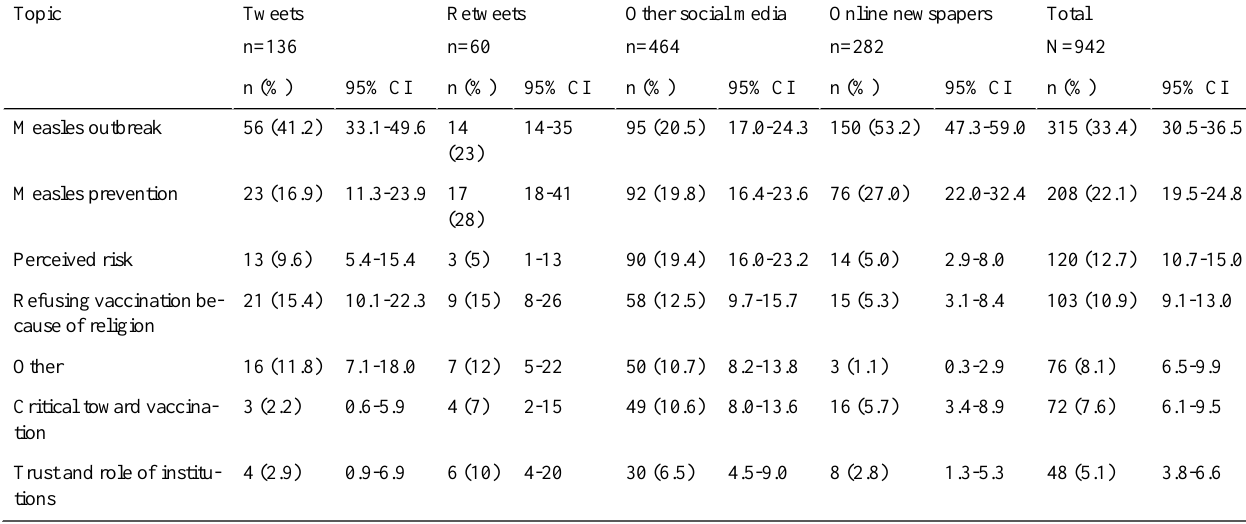
Table 4. Topics of coded measles-related tweets, retweets, other social media messages, and online newspaper articles.